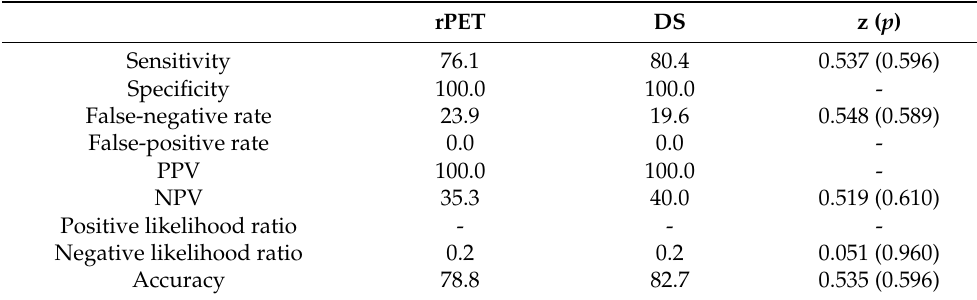
Table 6. Comparison of rPET and DS performance levels at interim PET-CT in predicting a therapy response at 24 months. Values are expressed as